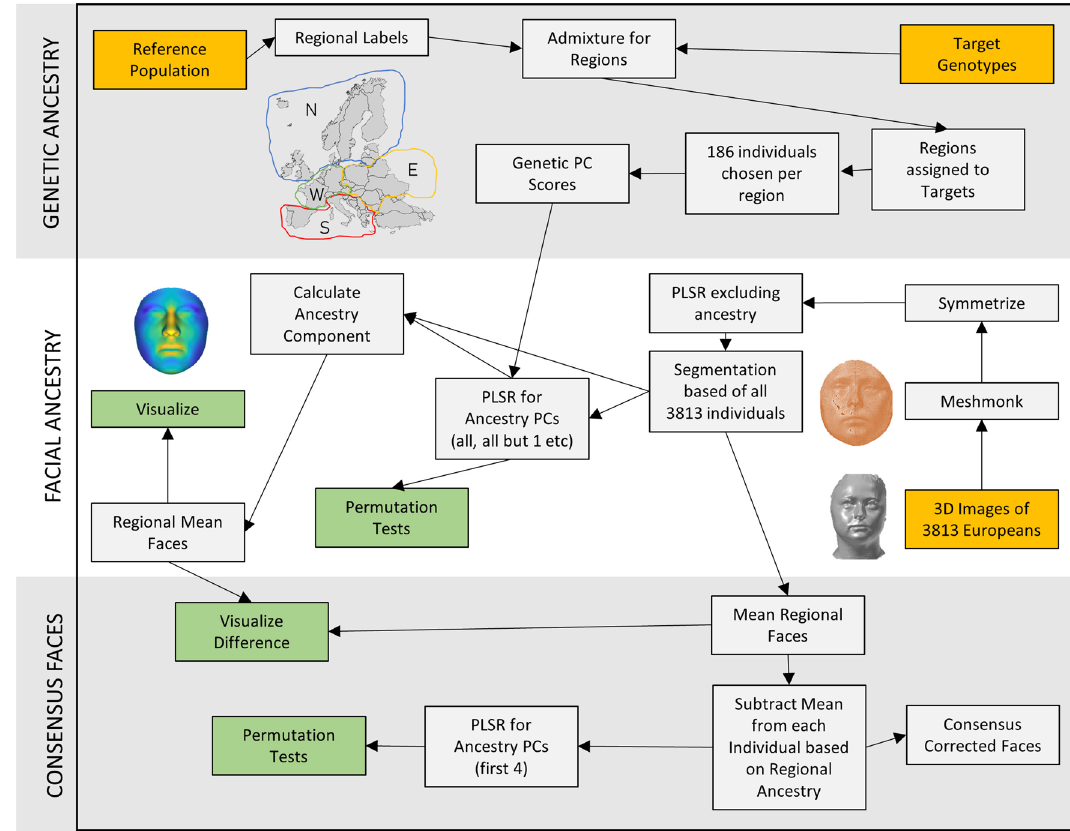
Figure 1. Visual overview of the computational approach to facial landmarking and association testing that was utilized in this study. Yellow indicates input data, green indicates